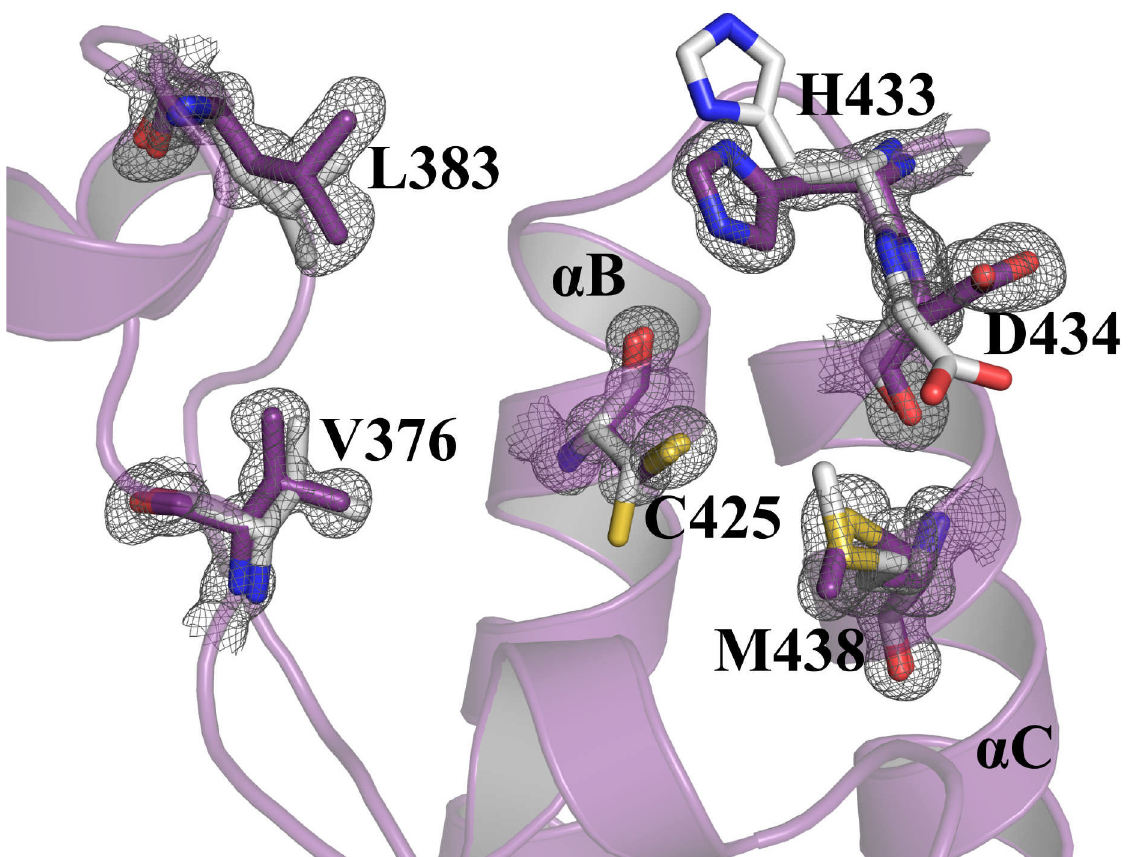
Fig 5. Superposition of BC and ZA loop regions of BD2-H4K5ac complex (PDB Id: 2E3K) and apo- form. Binding site residues (purple) in the apo- form demonstrating conformations different to that observed in the BD2-H4K5ac complex structure (grey). The side chain of C425 and M438 are flipped in the apo- form compared to the H4K5ac structure. The residues near the binding site region, which possess alternate conformations, are shown as sticks. |2Fo|-|Fc| map of the residues contoured at 1.0 σ . The hydrogen bonds are shown as broken